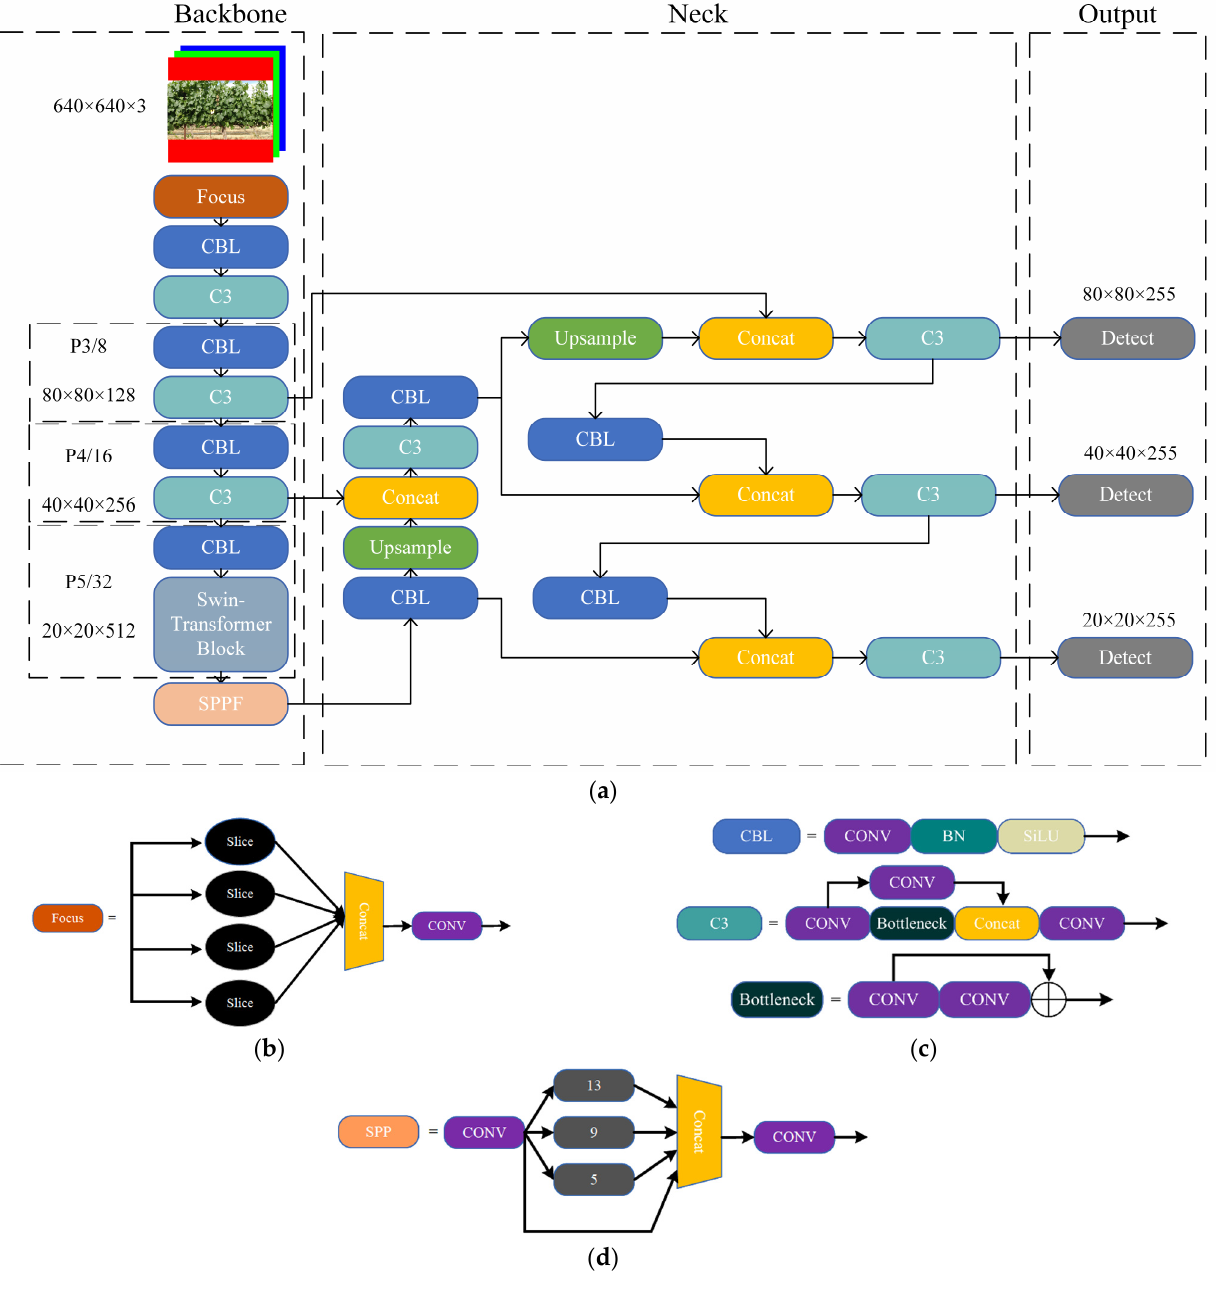
Figure 4. ( a ) Integrated architecture of Swin-transformer-YOLOv5; layers of ( b ) focus; ( c ) CBL and cross-stage partial (CSP) bottleneck with 3 convolutions (C3); and ( d ) spatial pyramid pooling (SPP), where CONV, Concat, BN, SiLU, and ADD ( ⊕ ) refer to convolutional, concatenate, batch normalization, activation function of sigmoid linear unit, and feature fusion with the number of channels unchanged. P refers to the specific layer of feature map.